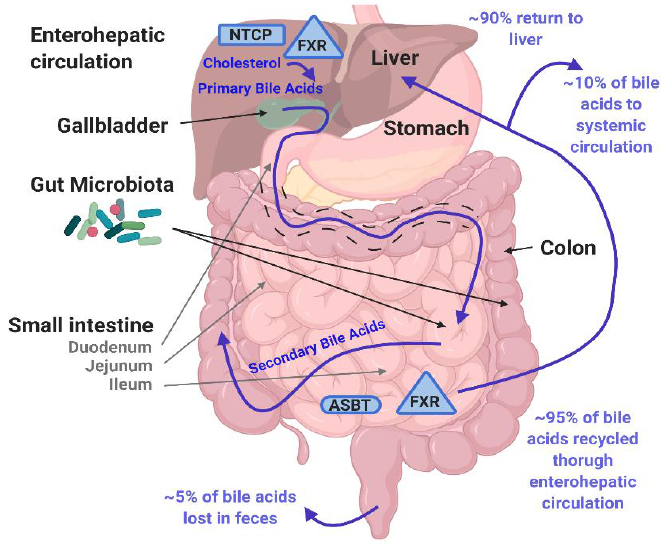
Figure 1. Bile acid pathways. ( A ) Primary bile acids (blue) are synthesized from cholesterol in the liver. Bacteria in the intestine convert primary bile acids to secondary bile acids (green) through dehydroxylation or epimerization. Carbons 3, 7, and 12 are indicated in red. Bile acids can be conjugated to glycine or taurine (box). ( B ) The effect of bile acids tested individually on HuNoV GII.3 infection of enteroids [1]. (cid:88) = permitted infection, X = did not permit infection, (cid:88) /– = intermediate effect, NT = not tested at 500 µ M due to cytotoxic effects (derived from Murakami et al., 2020 [1]). ( C ) Fold change in GII.3 genome equivalents correlates with the hydrophobicity indices of the bile acid used during infection. The solid line depicts the best-fit linear regression ( R 2 = 0.73, p < 0.01). The Pearson correlation coefficient ( r ) and p value ( p ) are noted (from Murakami et al., 2020 [1]).